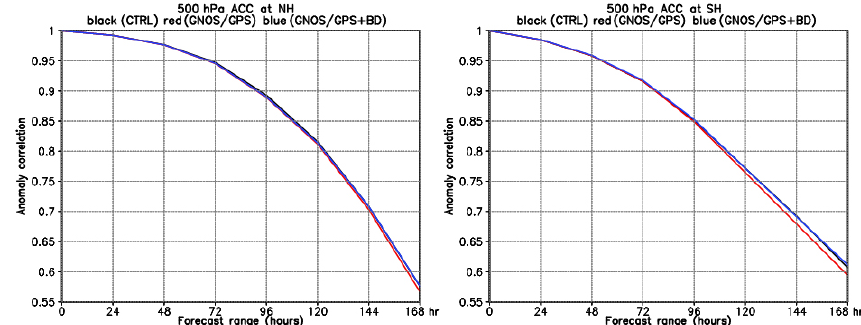
Figure 9. Comparison of the anomaly correlation coefficients of the without-GNOS-RO-data reference case (black line) and the other cases, assimilated GPS GNOS RO data only (red line), and assimilated GPS and BDS GNOS RO data (blue line). The left and right panels show the results of the Northern and Southern Hemisphere, respectively.